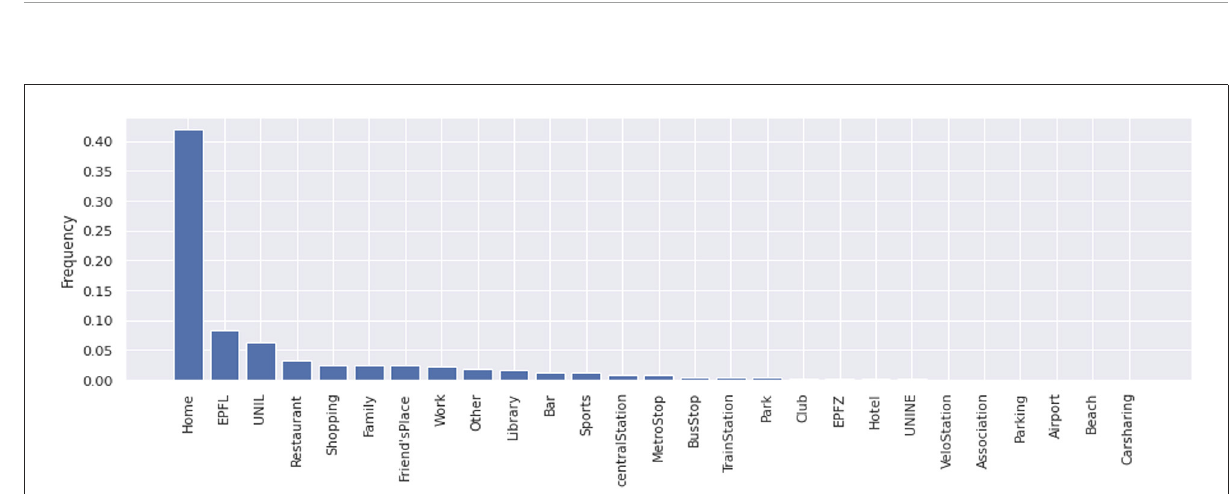
FIGURE1 Semantic labels in Breadcrumbs and their relative frequency, obtained after HST-DBSCAN